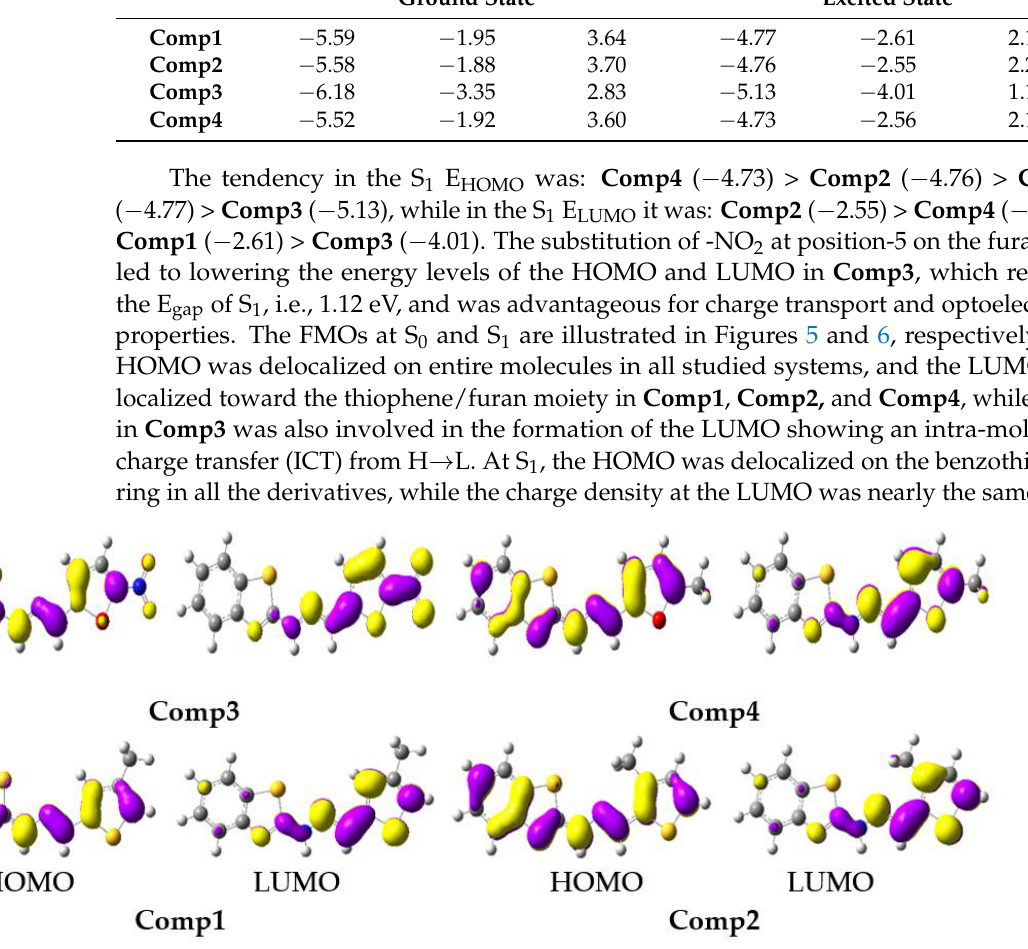
Figure 5. The frontier molecular orbitals distribution of benzothiazoles at a ground state (contour value = 0.035).